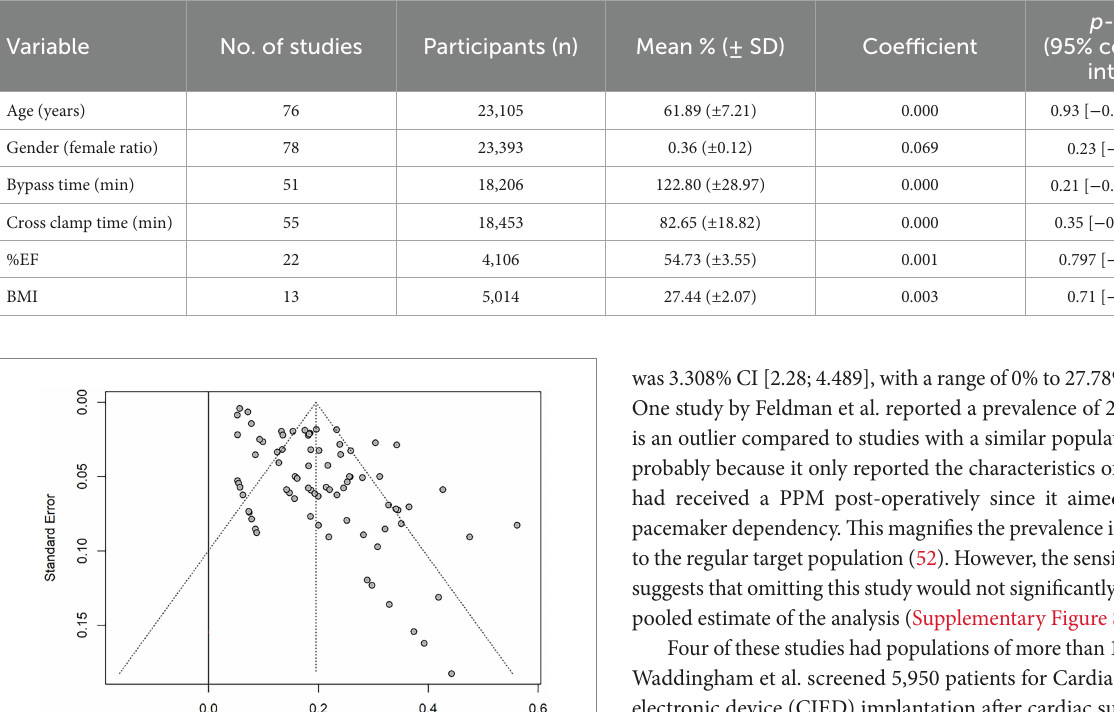
TABLE 4 Meta regression of selected variables and permanent pacemaker (PPM) implantation rate with random effects model (REM).